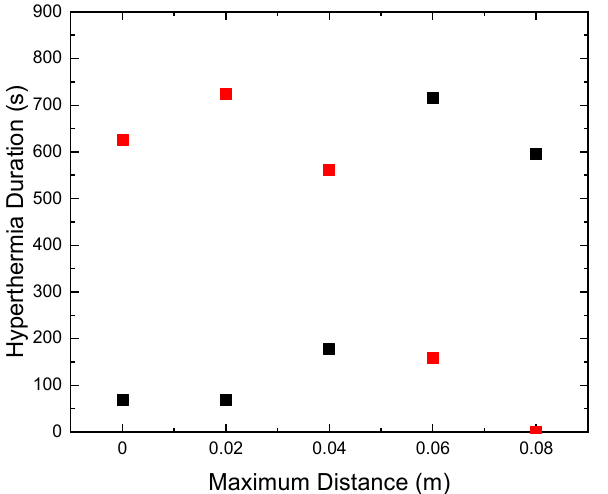
Figure 5. Duration time that HTP remained above 4 °C (red) and CTP (black) in MPH window (4–8 °C) for various values of maximum coil displacement.